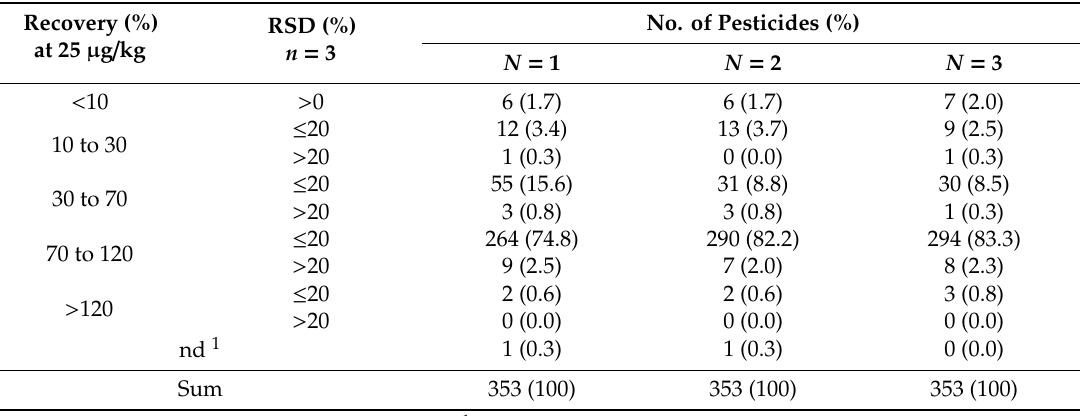
Table 1. Number of acetonitrile-hexane partitioning rounds ( N = 1, 2, and 3) and distribution of recovery results for 353 target pesticides. Each partitioning round was conducted with acetonitrile extraction using “quick, easy, cheap, e ff ective, rugged, and safe” method (QuEChERS) original salts (NaCl and MgSO 4 ) and dispersive solid-phase extraction (dSPE) cleanup using primary-secondary amines (PSA) sorbent. RSD—relative standard